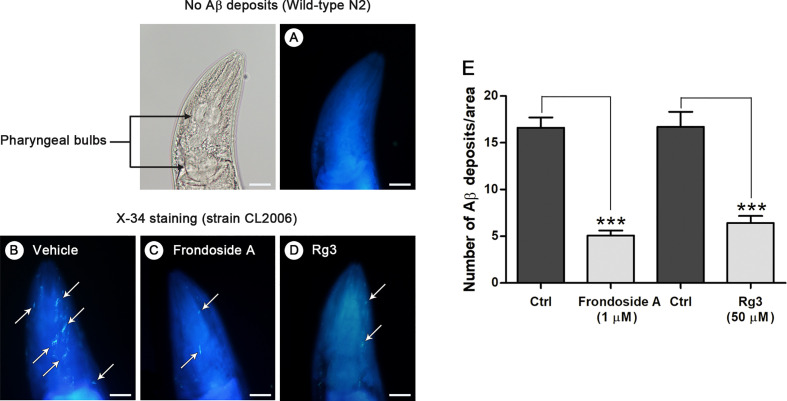
Aβ deposits in transgenic C. elegans CL2006 fed with or without frondoside A. Representative images of X-34 staining in the C. elegans wild-type N2 (A) and transgenic strain CL2006 treated with vehicle (B) or frondoside A at 1 µM (C) or ginsenoside-Rg3 at 50 µM (D). White arrows indicate Aβ reactive deposits in the worm head, which is separated from body by pharyngeal bulb region (black arrows). Scale bar represents 20 µm. (E) Quantitative analysis of Aβ deposits in the head region of transgenic strain CL2006 compared between control (Ctrl) and different treatment groups. The quantity is expressed as mean number ± SEM of Aβ deposits/area of the individual worm’s head region from three different assays with a total of 69 worms (23 worms for each analysis) (***p < 0.001).